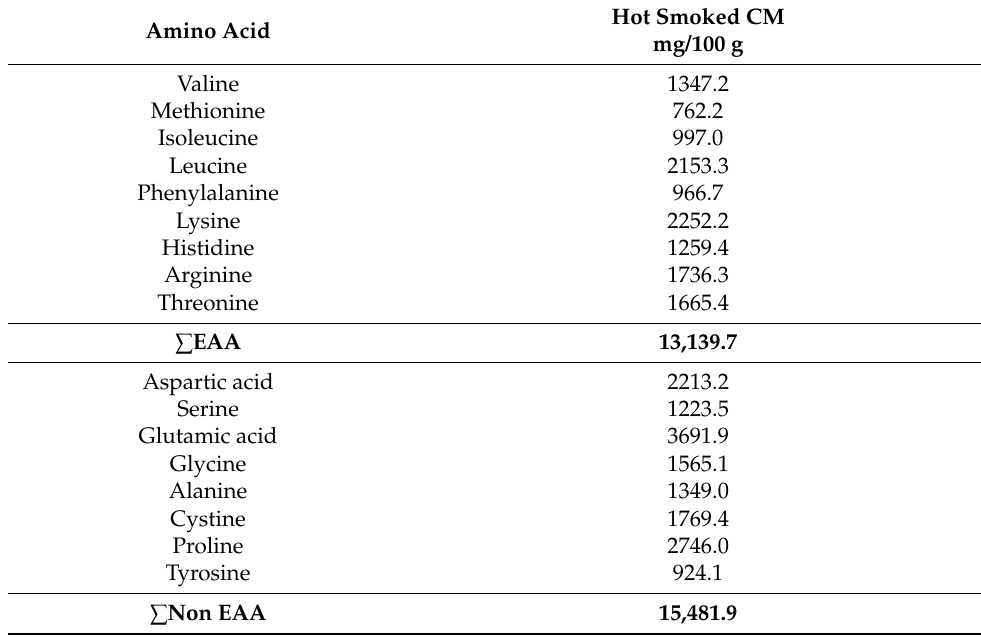
Table 2. Amino acid content (mg/100 g) in hot smoked CM